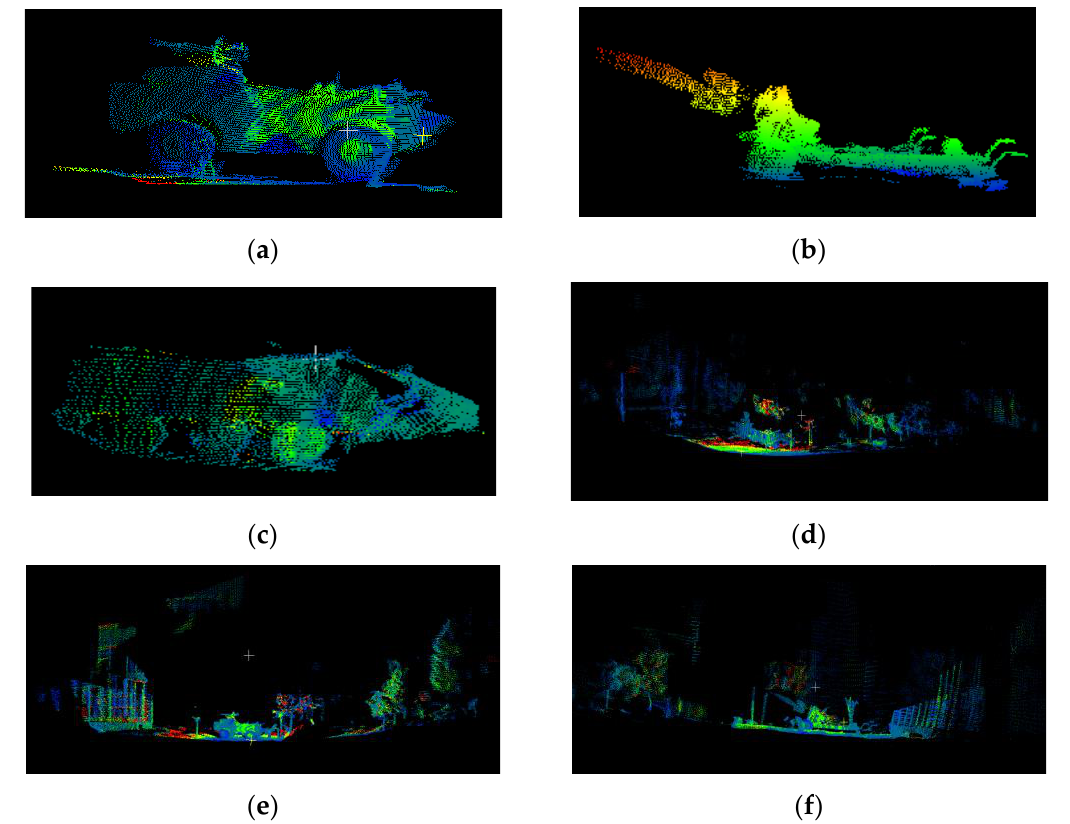
Figure 6. Models and scenario of real data set, ( a ) Missile vehicle. ( b ) Cannon. ( c ) An armored carrier. ( d – f ) contains three scenarios of the model.